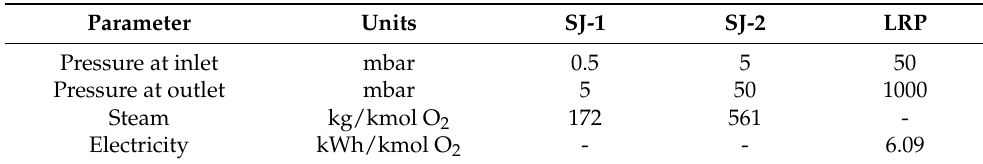
Table 4. Energy requirements of the vacuum system. In the titles, SJ-1 and SJ-2 stand for steam jet 1 and 2, respectively, while LRP means liquid ring